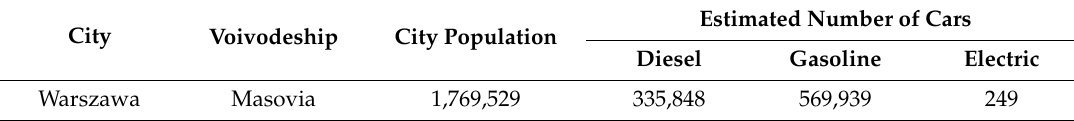
Table 4. Estimated number of cars, depending on the type of fuel for the city of Warsaw.